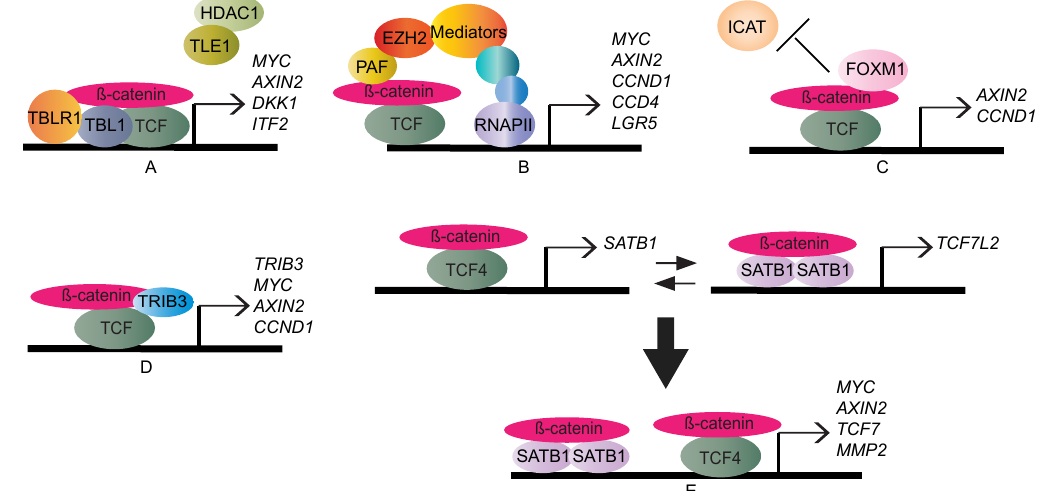
Figure 3. Schematic depicting the molecular mechanism of co-activators involved in TCF / LEF- dependent β -catenin transcriptional activities and their functional consequences. ( A ) TBL1 (Transducin β -like protein 1) and TBLR1 (TBL1-related protein) interact with nuclear β -catenin, and the interaction promotestheirbindingtothepromotersofWnttargetgenes. Subsequently, TLE1andhistonedeacetylase 1 (HDAC1), two transcriptional repressors, are displaced to initiate downstream transcriptional cascades. ( B ) PAF (PCNA-associated factor) recruits EZH2, a histone-lysine N-methyltransferase, to the β -catenin-TCF / LEF complex. Consequently, EZH2 and the Mediator complex recruit